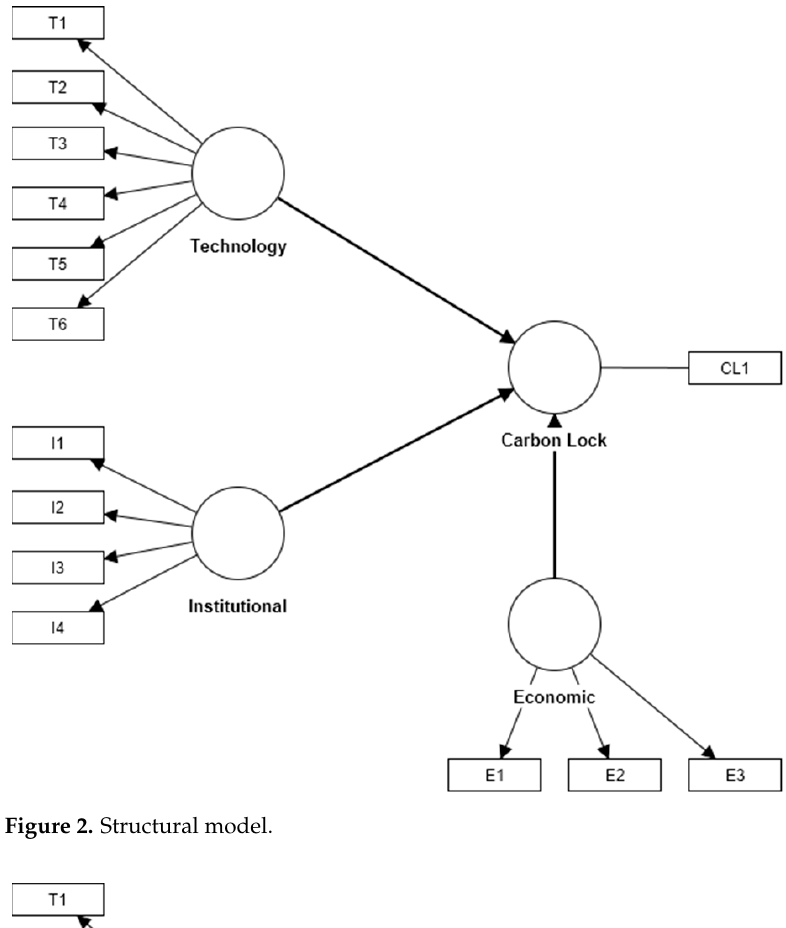
Figure 2. Structural model.